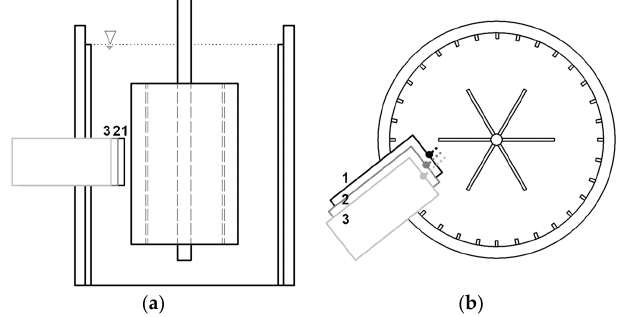
Figure 2. Scheme of the FBRM probe integrated into the rheometer at three different radial positions (the distance of each position from the middle point until the tips of the vane probe is shown as dash lines), each with an angle of 45 ◦ between the probe window and the flow direction; ( a ) vertical cut, ( b ) top